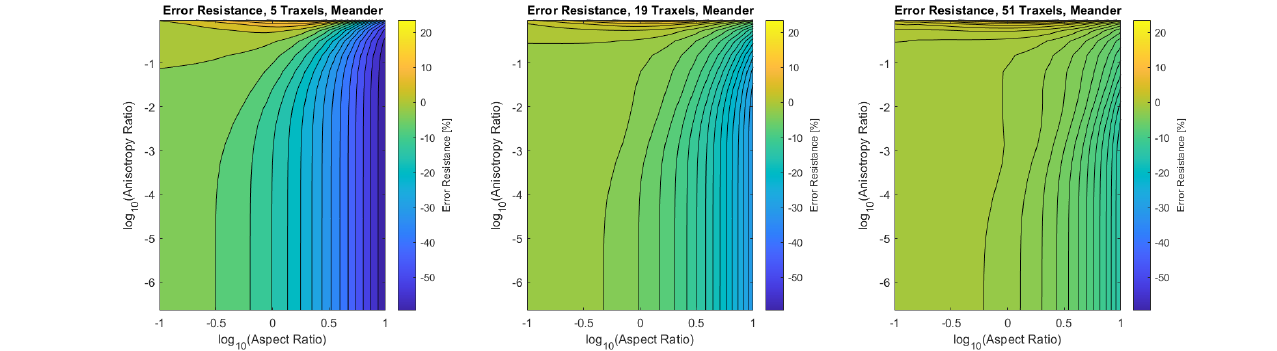
Figure 17. The error of the total resistance for the meandering case with different numbers of traxels. The RMS-error for the different numbers of traxels is, respectively, 24.33%, 10.26%, and